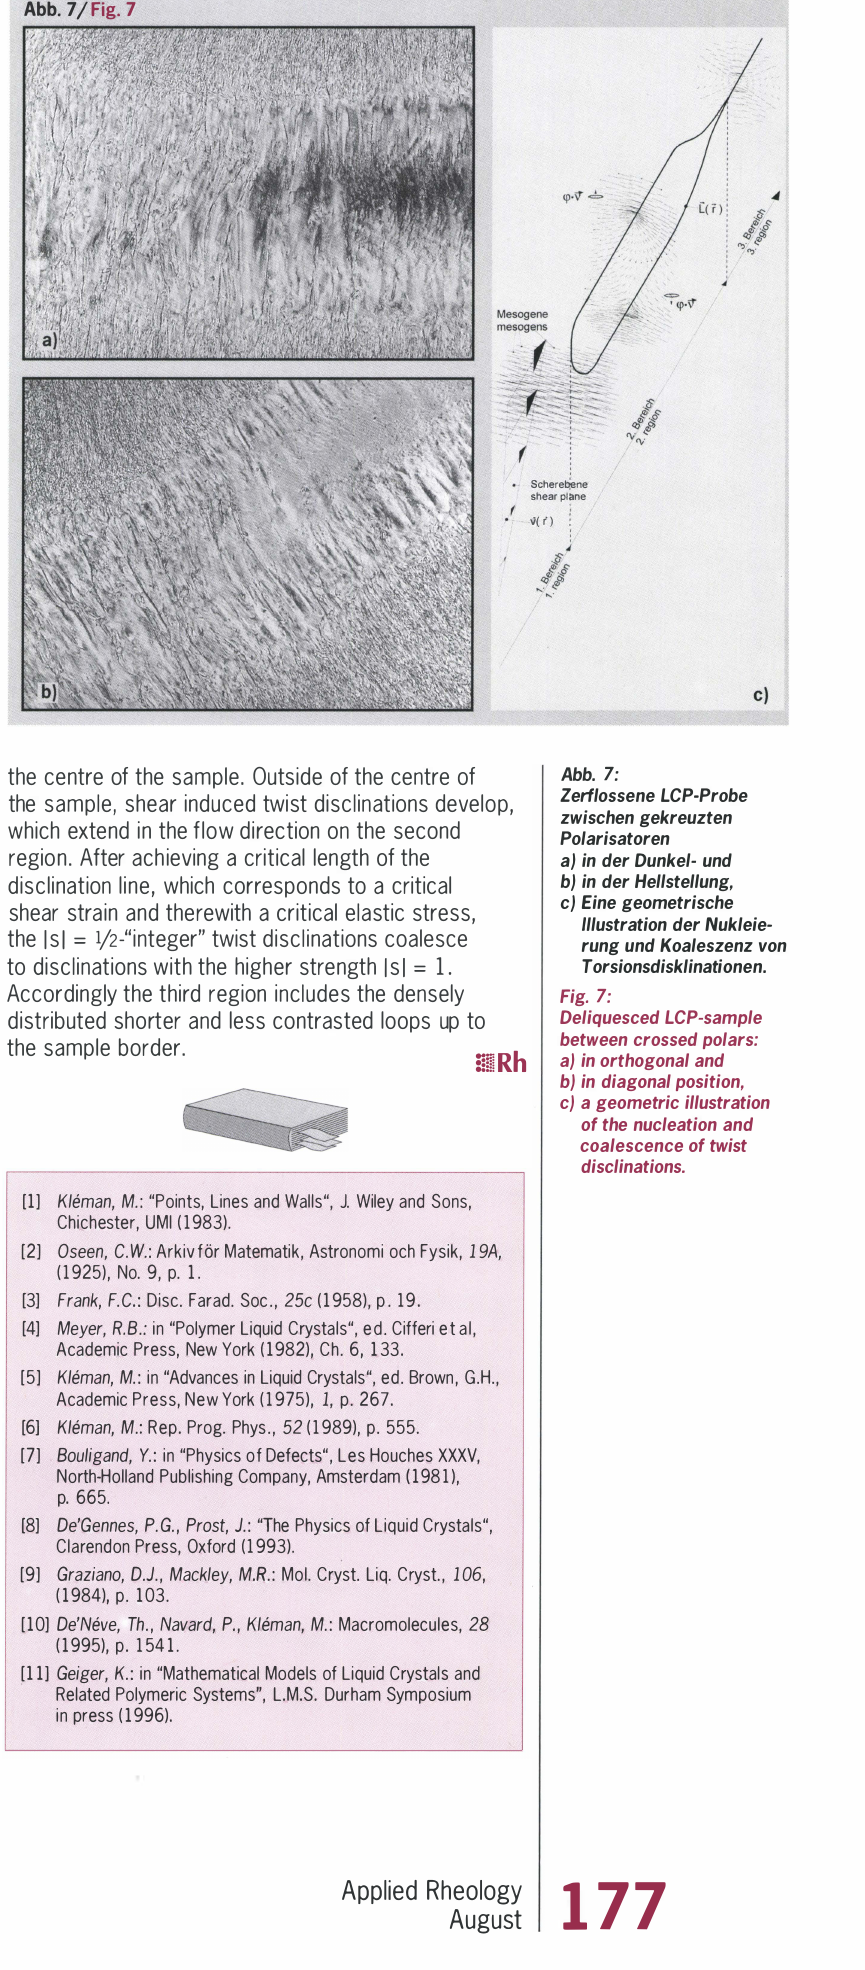
rung und Koaleszenz von Torsionsdisklinationen. Fig. 7: Deliquesced LCP-sample between crossed polars: a) in orthogonal and b) in diagonal position, c) a geometric illustration of the nucleation and coalescence of twist